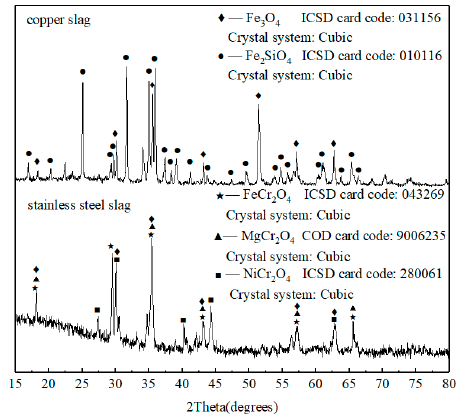
Figure 1. X-ray diffraction (XRD) patterns of waste copper slag and stainless steel